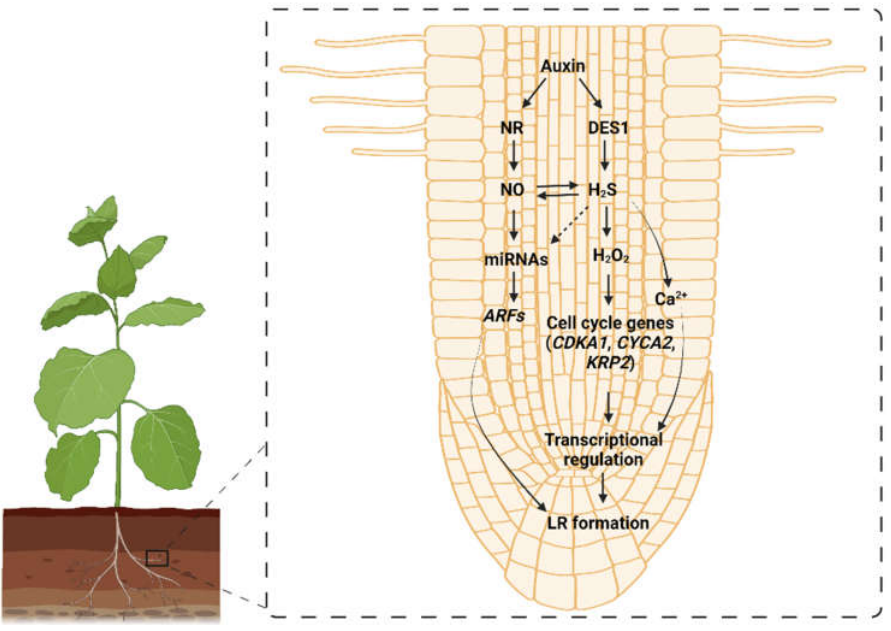
Figure 5. Schematic representation of the signaling pathways involving auxin, DES (cysteine desulfhydrase), NO (Nitric oxide), and hydrogen sulfide (H 2 S) interaction during lateral root formation in plants. The interaction between H 2 S and NO under the influence of auxin participates in the development of the lateral root via modulating the expressions and activities of different effector genes or proteins in a framework of regulatory pathways to permit root growth. miRNA: Micro RNA; ARFs: Auxin Response Factors; CDKA1 : Cyclin-Dependent Kinases gene; CYCA2 : cell cycle regulatory gene; KRP2 : Kip-Related Protein 2; NR: Nitrate reductase; LR: lateral root.